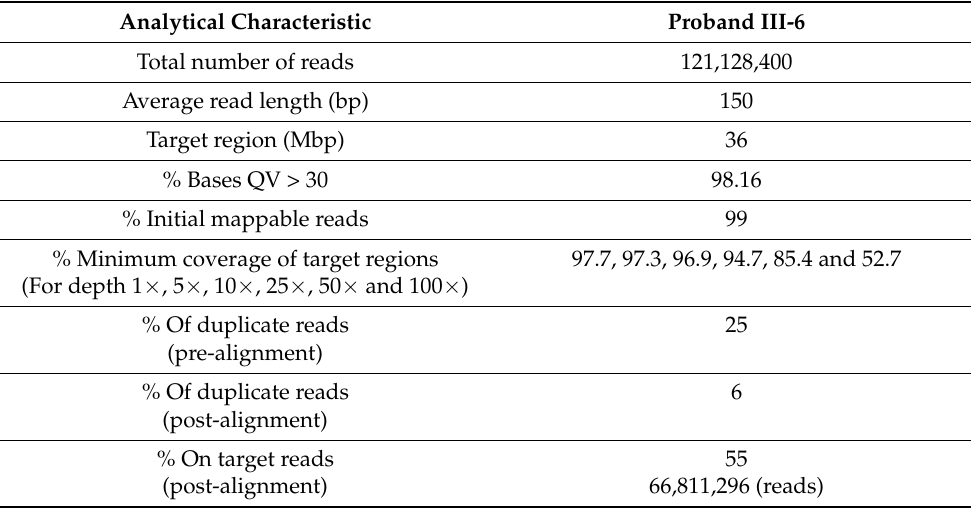
Table 1. The summary explanation of data analysis from the